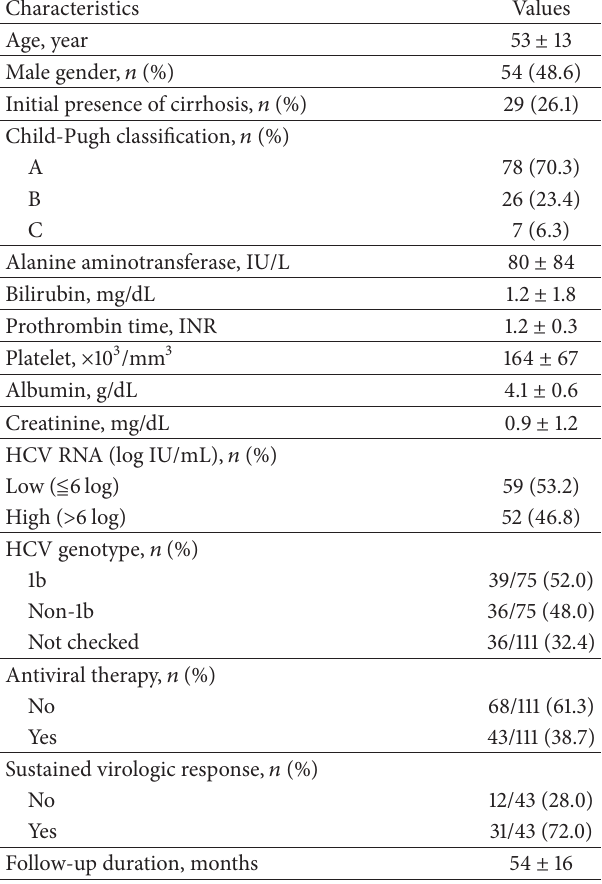
Table 1: Baseline characteristics of enrolled subjects.